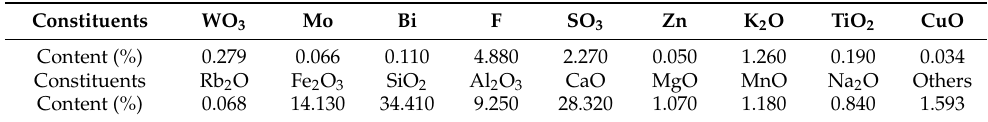
Figure 1. XRD analysis of tungsten ores. Table 1. Chemical compositions of tungsten ores